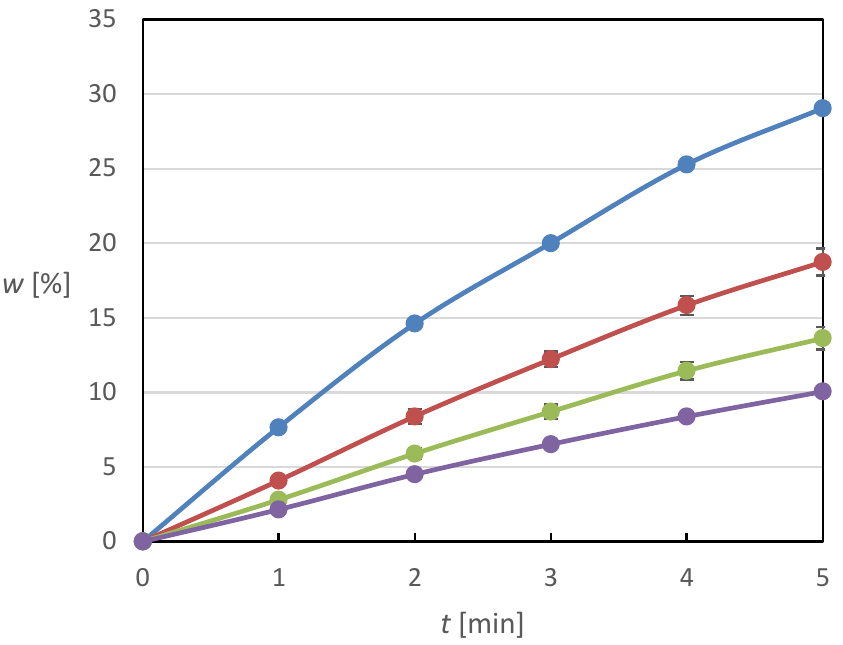
Figure 2. Dissolution profiles of tablets prepared by applying a 4 mg/mL MX THF solution including error bars (5 drops (cid:4) , 10 drops (cid:4) , 15 drops (cid:4) , 20 drops (cid:4) ), the curves are the connecting points of each data